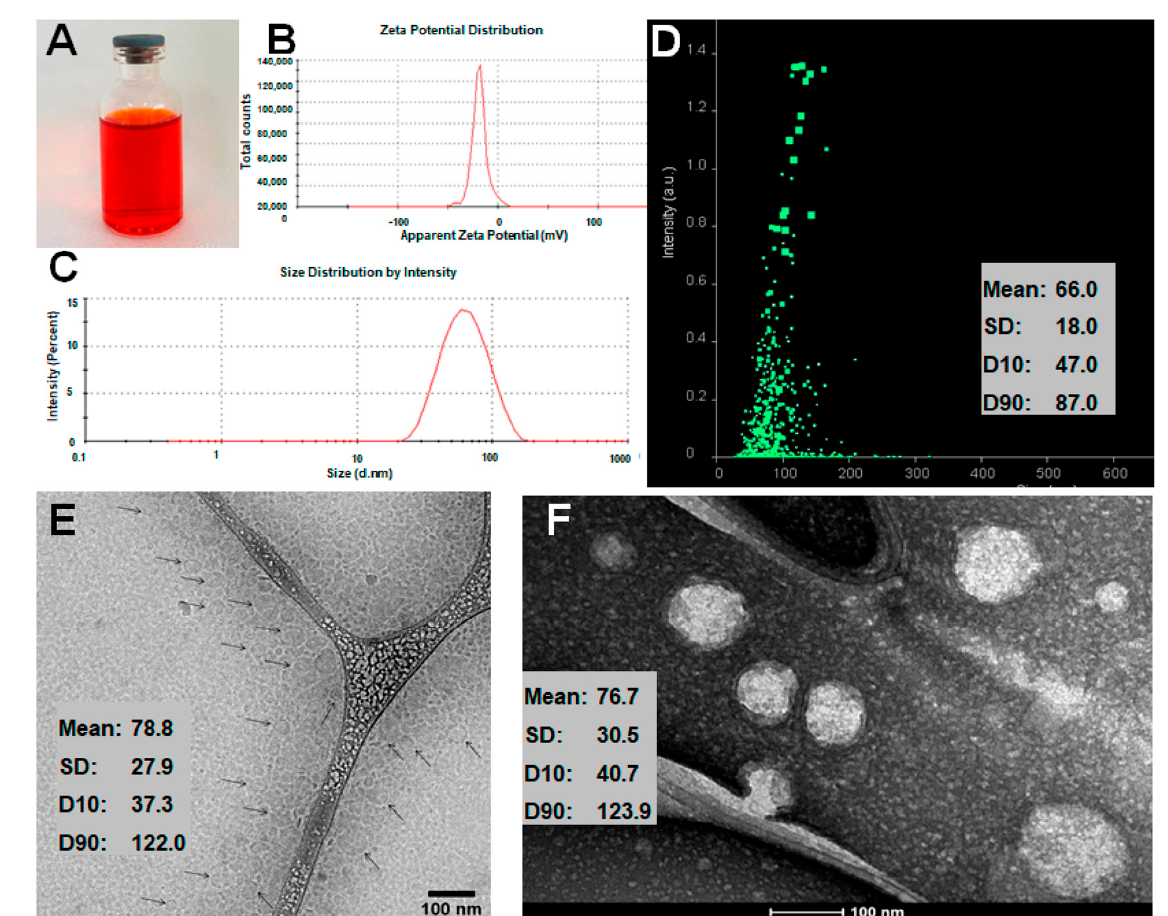
Figure 1. Characteristics of NLC-DOX. Image of NLC-DOX formulation ( A ); Zeta potential distribution determined by dynamic scattering of light and electrophoretic mobility ( B ); particle size distribution determined by DLS ( C ); particle size distribution determined by NTA ( D ); cryo-TEM image ( E ); and TEM image of NLC-DOX ( F ). Abbreviations: DOX, doxorubicin; NLC, nanostructured lipid carrier; DLS, dynamic light scattering; NTA, nanoparticle tracking analysis; TEM, transmission electronic microscopy; SD, standard deviation; D10, the size point below which 10% of NLC-DOX is contained; D90, the size point below which 90% of NLC-DOX is